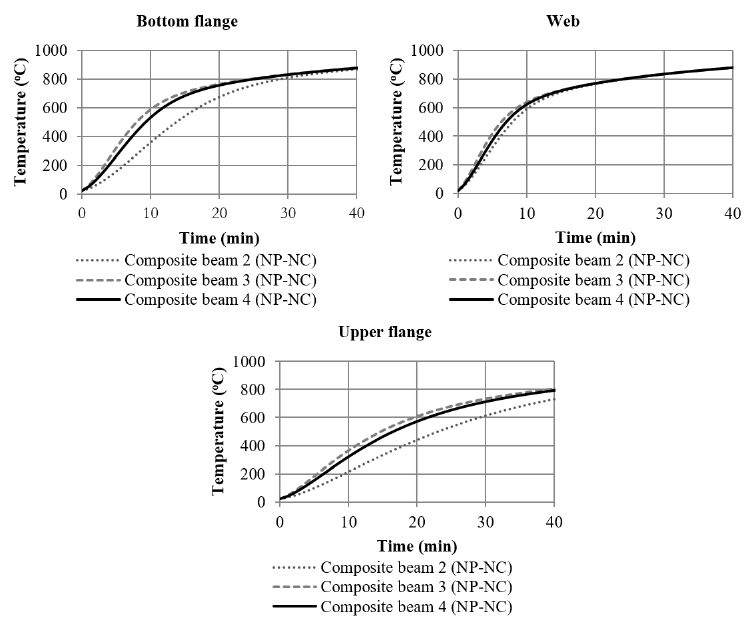
Figure 13. Temperature development in each part of the steel profiles up to 40 minutes.